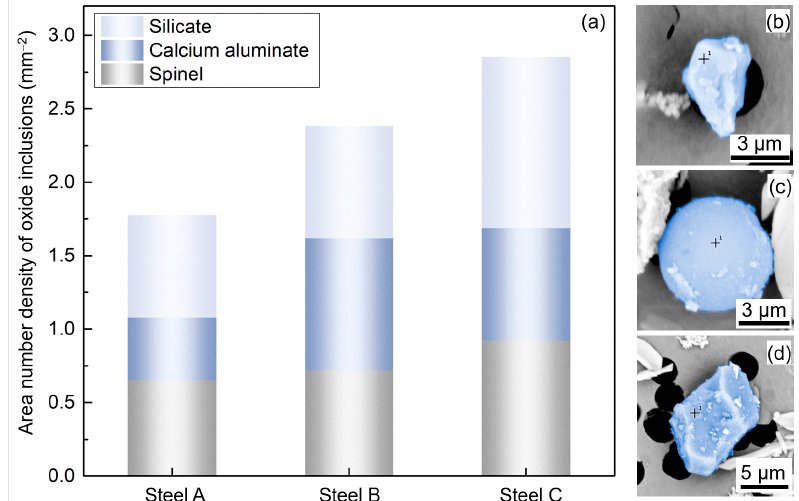
Figure 3. Characterization of the oxide inclusions: ( a ) Area number densities sorted by inclusion type and typical morphologies of the oxide inclusions; ( b ) silicate inclusion; ( c ) calcium aluminate inclusion; ( d ) spinel inclusion.